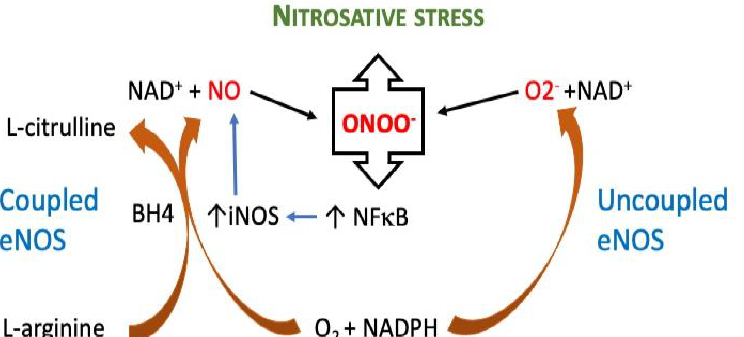
Figure 2. Pathway mechanism of coupled and uncoupled eNOS. Uncoupling eNOS causes nitrosative stress. By oxidizing its cofactor, tetrahydrobiopterin (BH4), the endothelial isoform of nitric oxide synthase (eNOS) becomes uncoupled, generating a superoxide anion (O 2 ). Superoxide then reacts with nitric oxide (NO), which is generated by neighbouring, still-coupled eNOS, to form the potent oxidant peroxynitrite (ONOO − ), which in turn, increases the activity of nuclear factor kappa B (NFB) in the cell. When the nuclear factor kappa B (NF- κ B) is activated, the inducible nitric oxide synthase (iNOS) is expressed, which creates large amounts of NO that combine with eNOS-generated O 2 to enhance the synthesis of ONOO − .